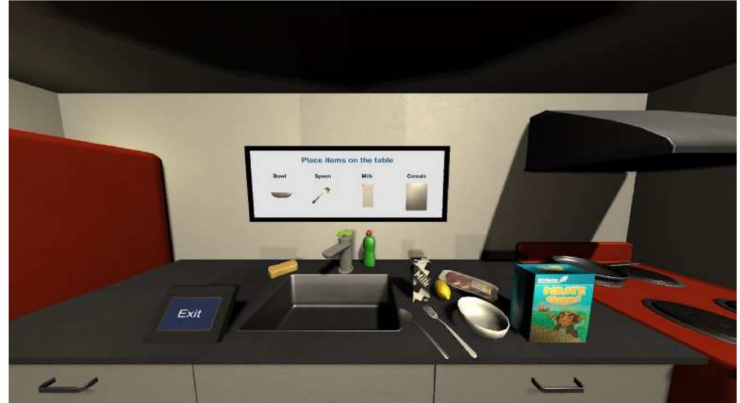
Figure 5. Breakfast